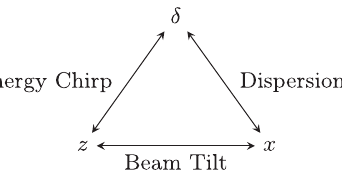
FIG. 5. Flow diagram to illustrate the correlation between the energy ( δ ), transverse position ( x ) and longitudinal position ( z ) assuming strict monotony and